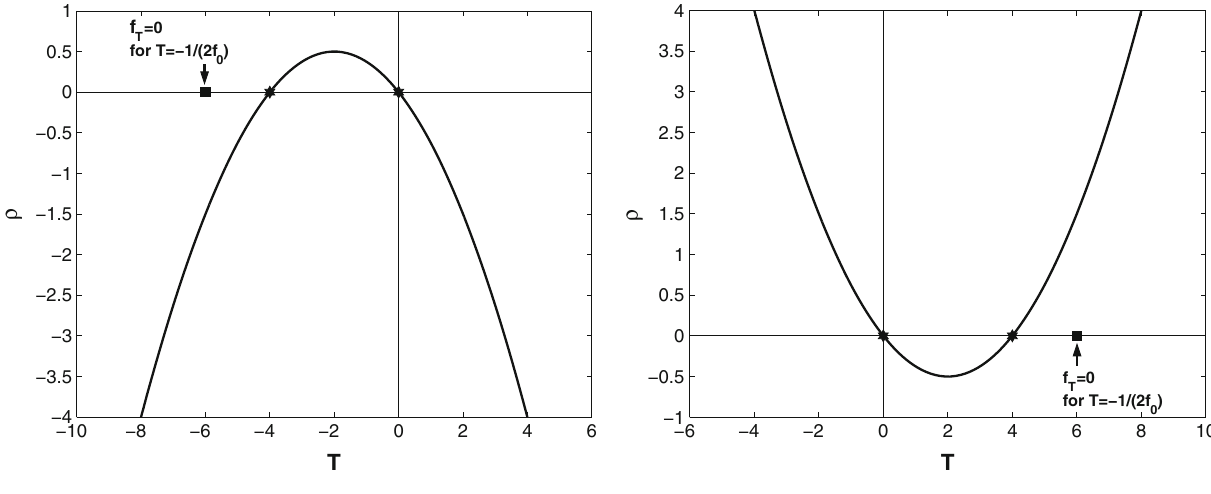
, which follows from the constraint equation (26) for N = 2. The parameter f 0 = 1 2 K